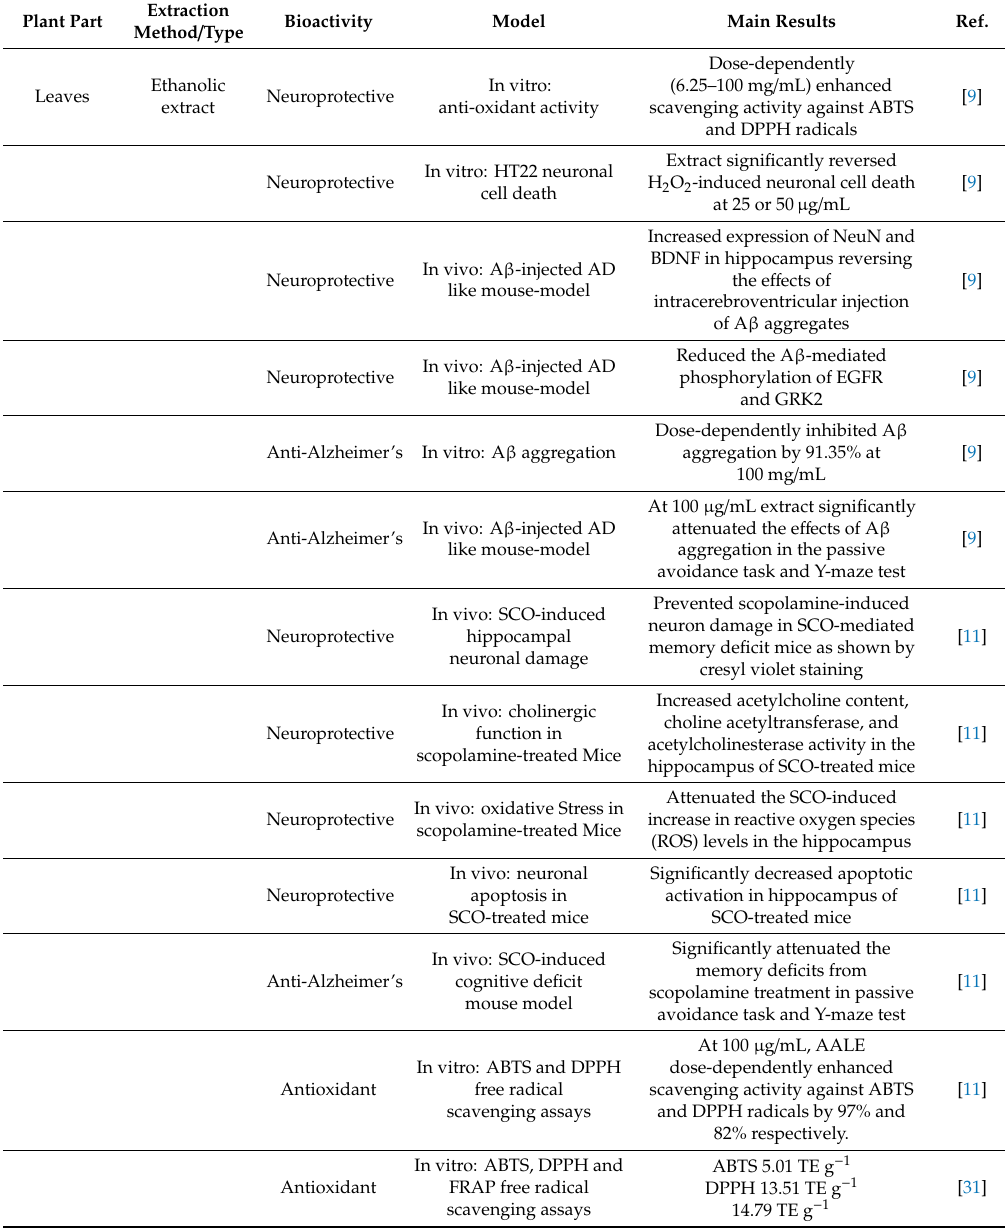
Table 1. Plant part, extraction methods and biological activities and